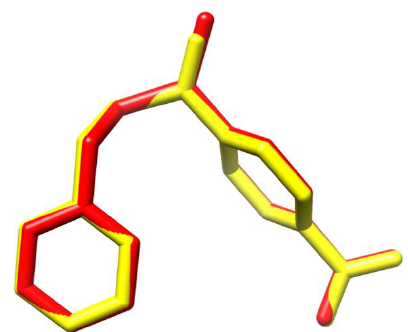
Figure 2. Inhibition of phospholipases A 2 (PLA 2 ) activity by I. Different concentrations were pre-incubated with 20 µ g of PLA 2. Results are shown as mean ± SEM, n = 6. Molecules 2019 , 24 , x FOR PEER REVIEW